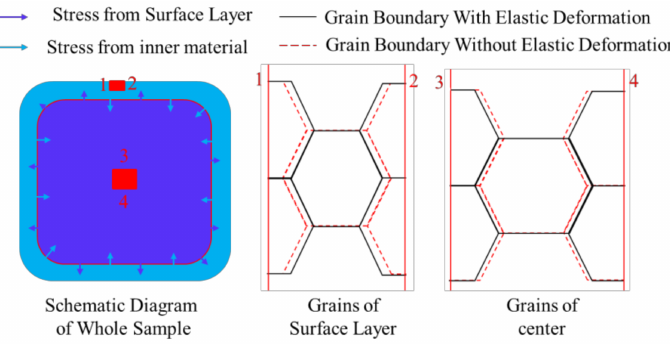
Figure 7. Deformation of sample after quenching